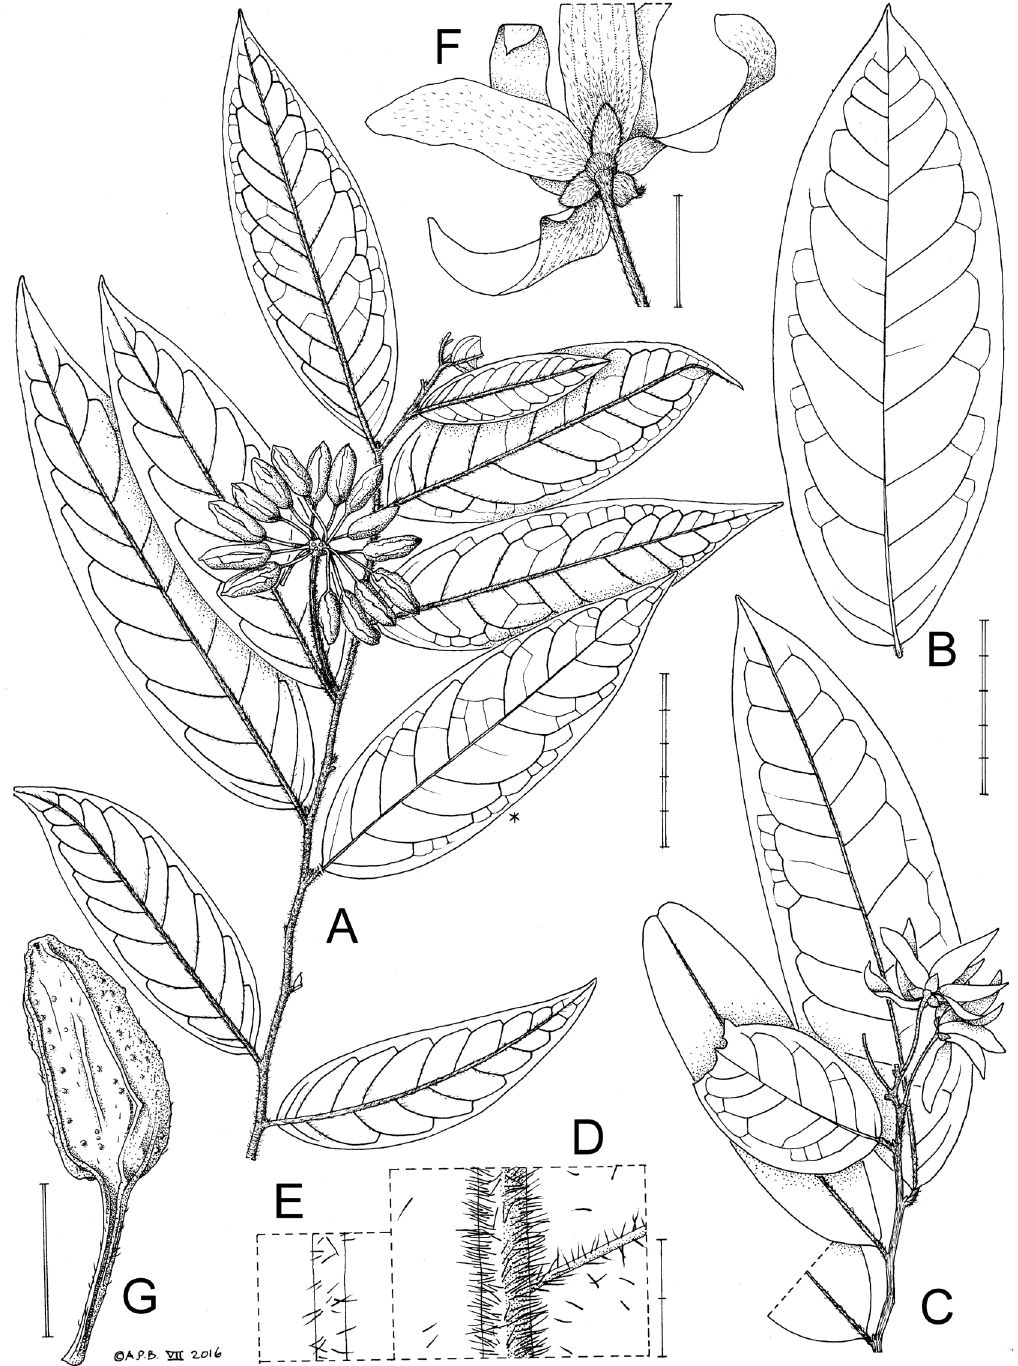
Fig. 5. Huberantha asymmetrica I.M.Turner & Utteridge sp. nov. A . Leafy shoot bearing fruit (leaf marked with an asterisk showing adaxial surface, rest with abaxial view). B . Leaf (adaxial view) showing distinct asymmetry. C . Flowering shoot. D . Leaf lamina abaxial midrib region showing indumentum. E . Leaf lamina adaxial midrib region showing indumentum. F . Flower viewed from below. G . Monocarp sectioned longitudinally. Scale bars: graduated single bar = 2 mm; double bar = 1 cm; graduated double bar = 5 cm. Drawn from BSIP 12085 (A in part, D, E); BSIP 9859 (A in part, G); BSIP 12719 (C); BSIP 12261 (B). Drawn by Andrew